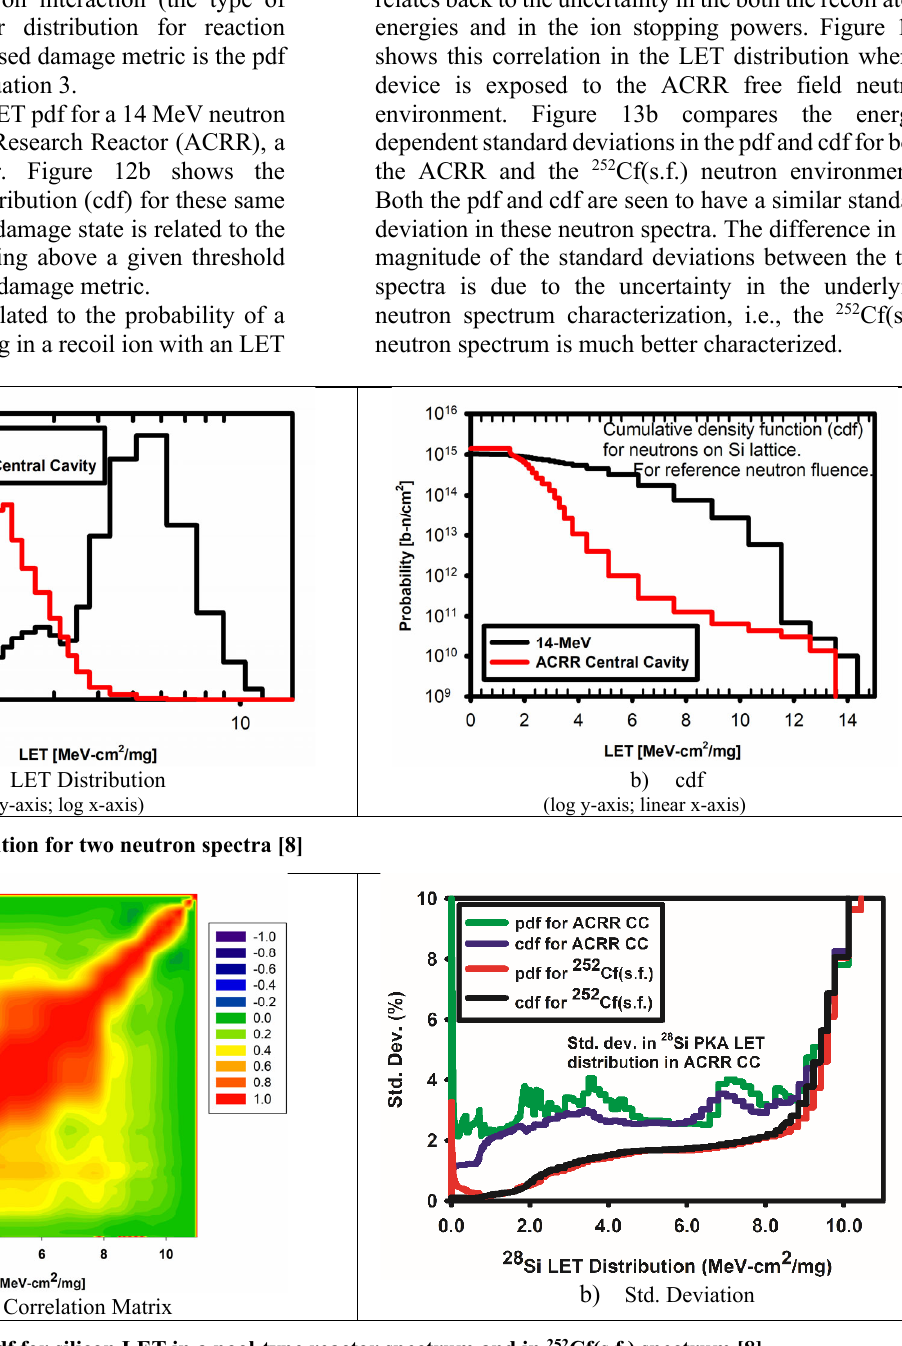
Fig. 13. Uncertainty in the cdf for silicon LET in a pool-type reactor spectrum and in 252 Cf(s.f.) spectrum